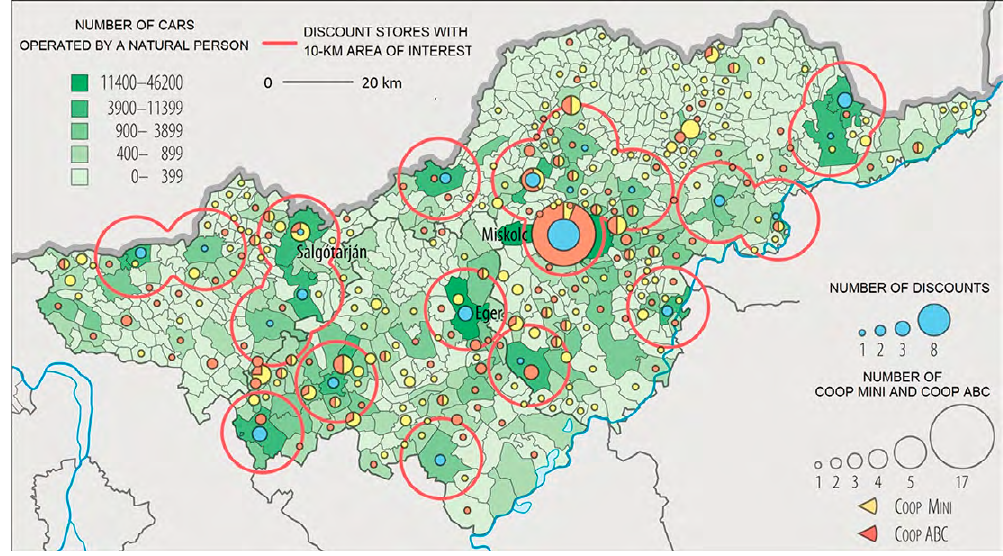
Figure 4. Distribution of discounters, Coop stores and car supply, 2020 Source: own research, drawn by Fanni